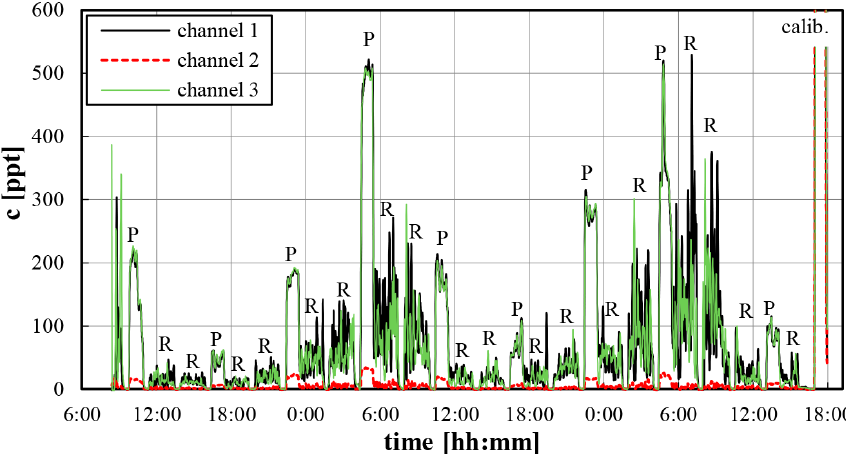
Figure 2. Mixing ratios (30s raw data) of the three LOPAP channels during test measurements at the university of Wuppertal. Periods marked with “P” show undiluted parallel ambient measurements (60min), while the REA measurements (dilute samples) are signed by “R” (120min). In between, regular zero measurements (30min) are performed.